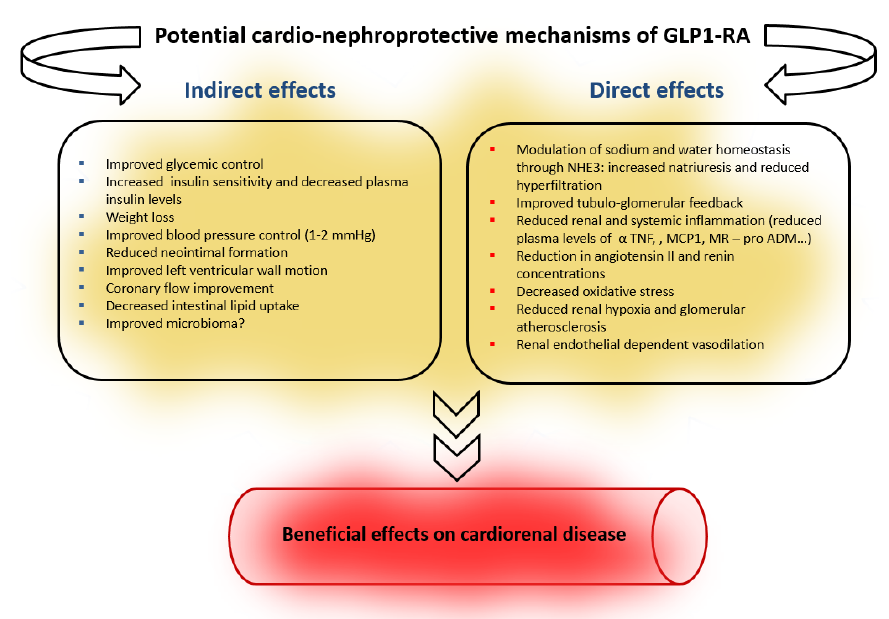
Figure 1. Potential mechanisms for the cardio-nephroprotective effect of GLP-1RA (modified